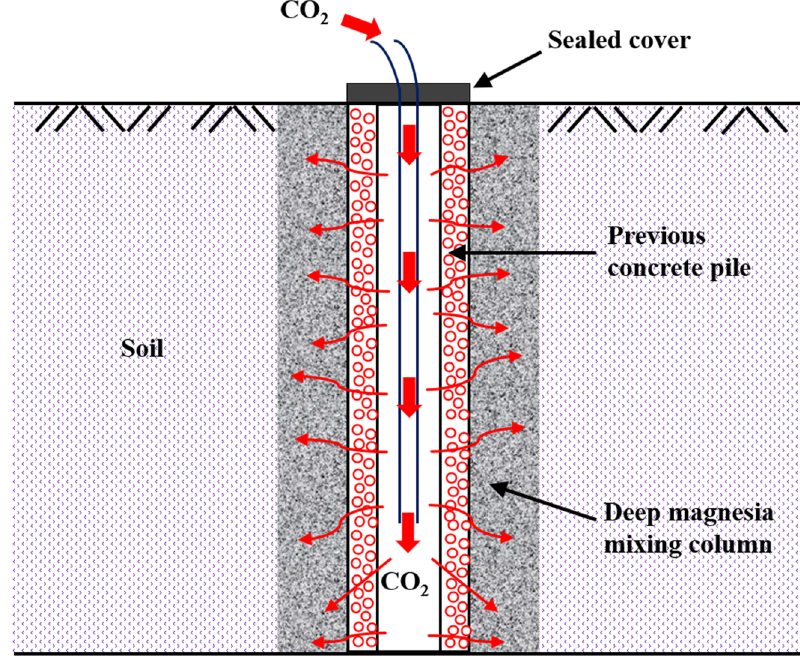
Figure 12. Schematic diagram of the carbonized composite pile.